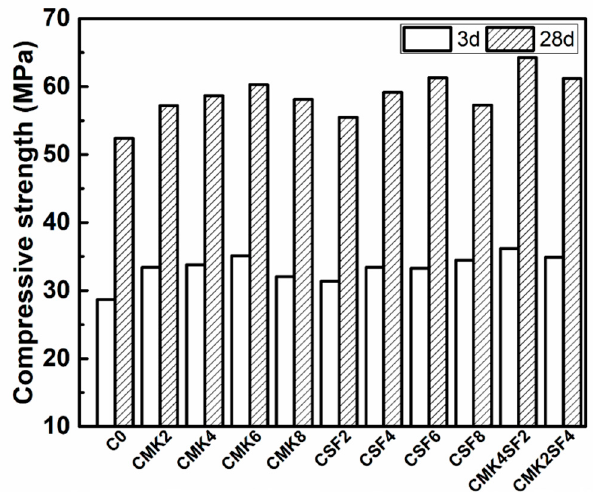
Figure 9. Effect of MK and SF on the compressive strength of SCC.